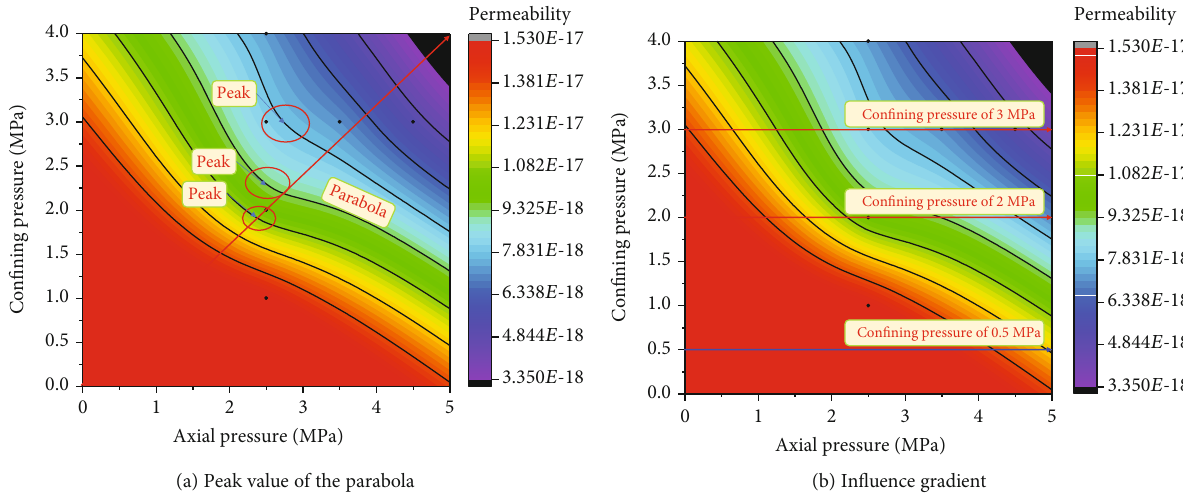
Figure 10: In fl uence of con fi ning pressure/axial pressure on the SBCB permeability.